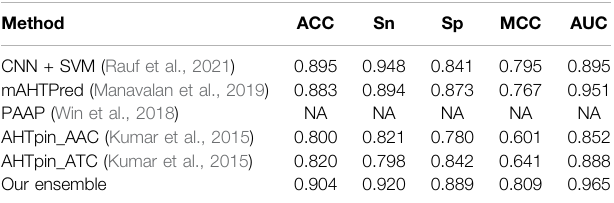
TABLE 3 | Performance evaluation of the proposed method using benchmarking dataset.